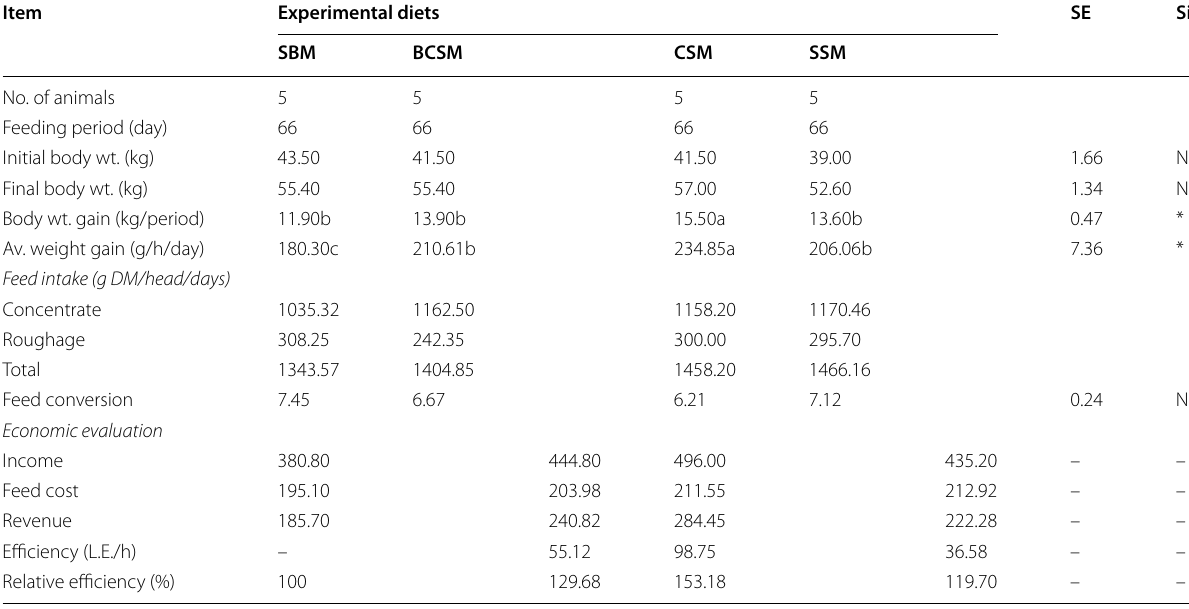
a, b and c: Means in the same row with different superscripts are significantly different at ( p < 0.01) SE, standard error; NS, nonsignificant